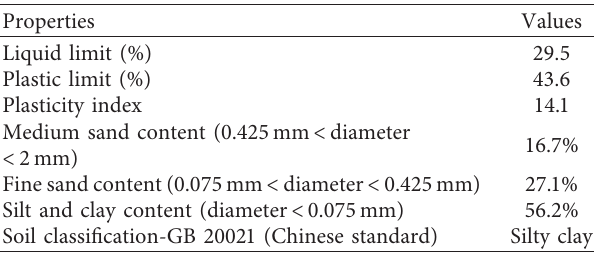
Table 1: Physical properties of